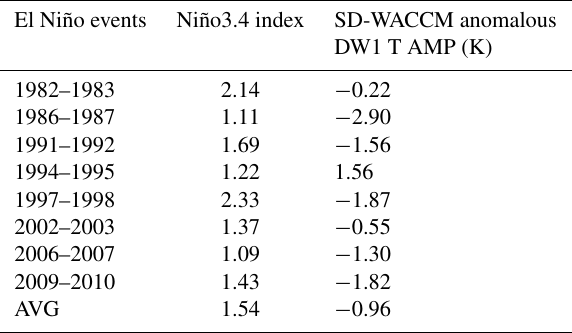
Table 1. The list of ENSO years with corresponding Niño3.4 indices and anomaly DW1 temperature amplitudes of the